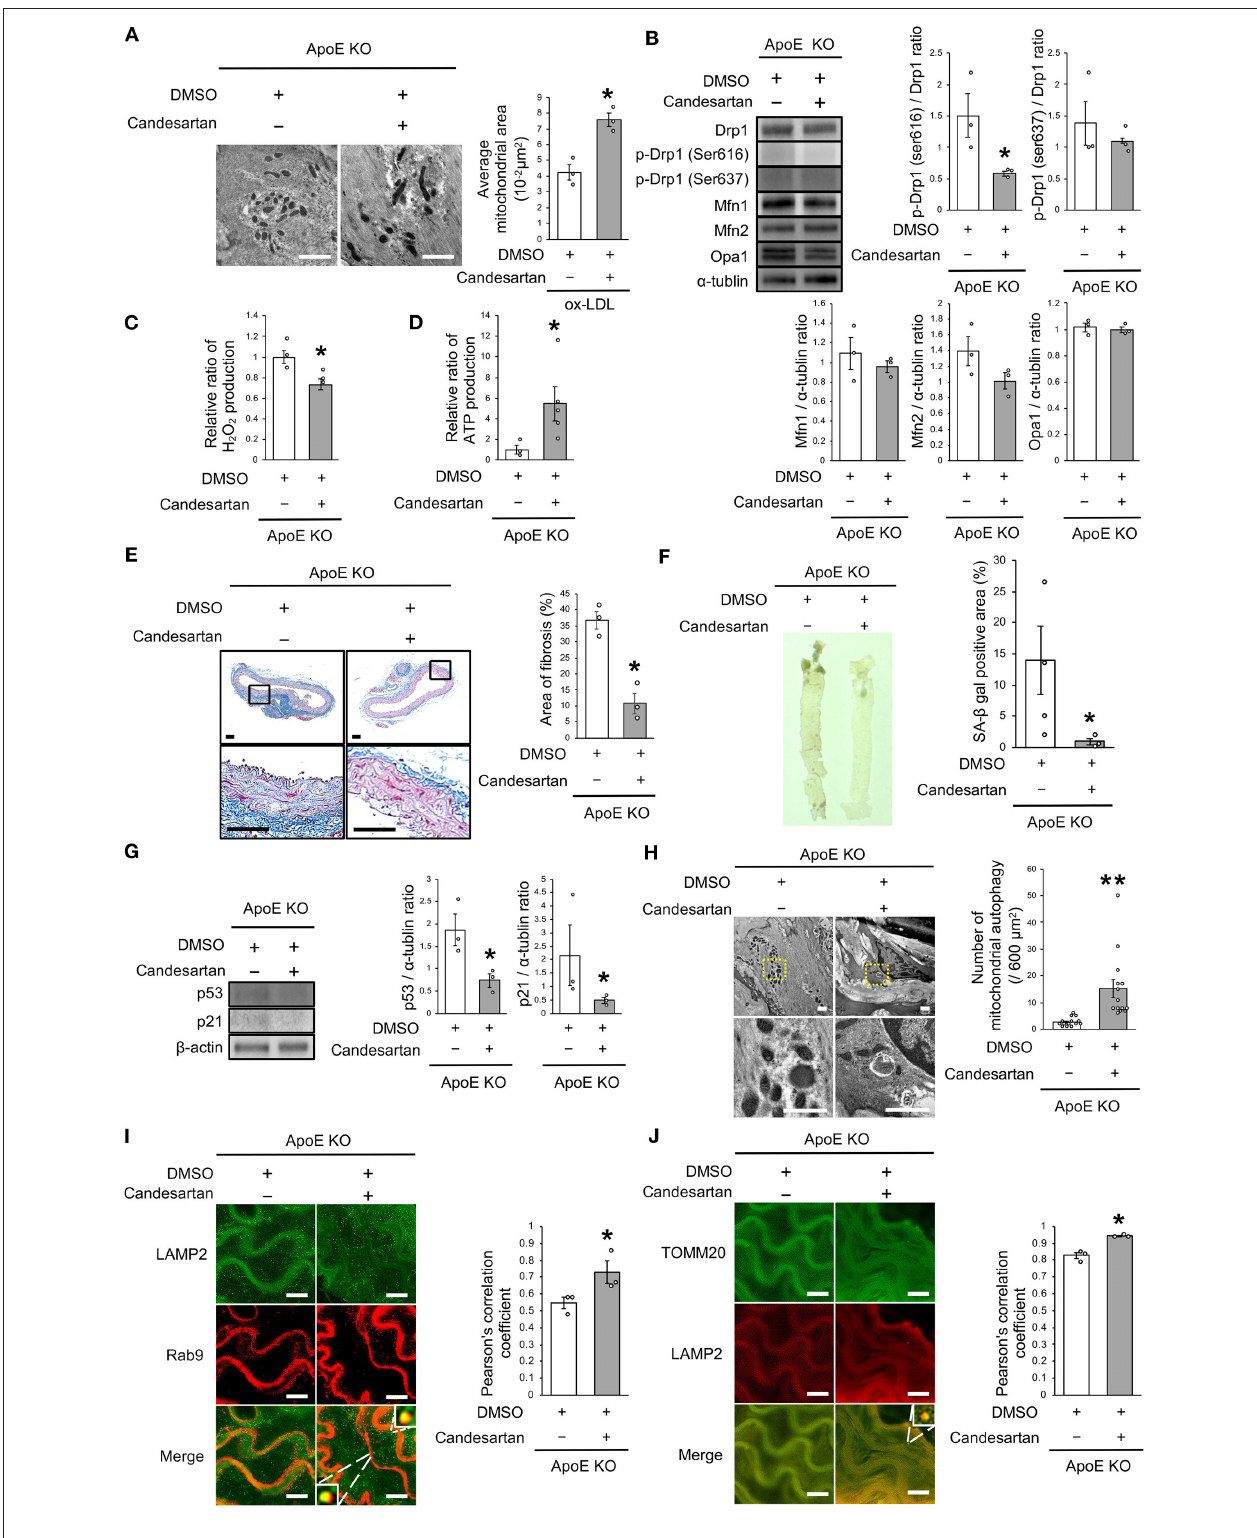
FIGURE 8 | AT1R inhibition improved the imbalance of excessive mitochondrial fission and induced Rab9-dependent mitochondrial autophagy, leading to anti-vascular senescence. (A) Electron microscopic images and quantitative analysis of mitochondria and average mitochondrial areas in ApoE KO mice treated